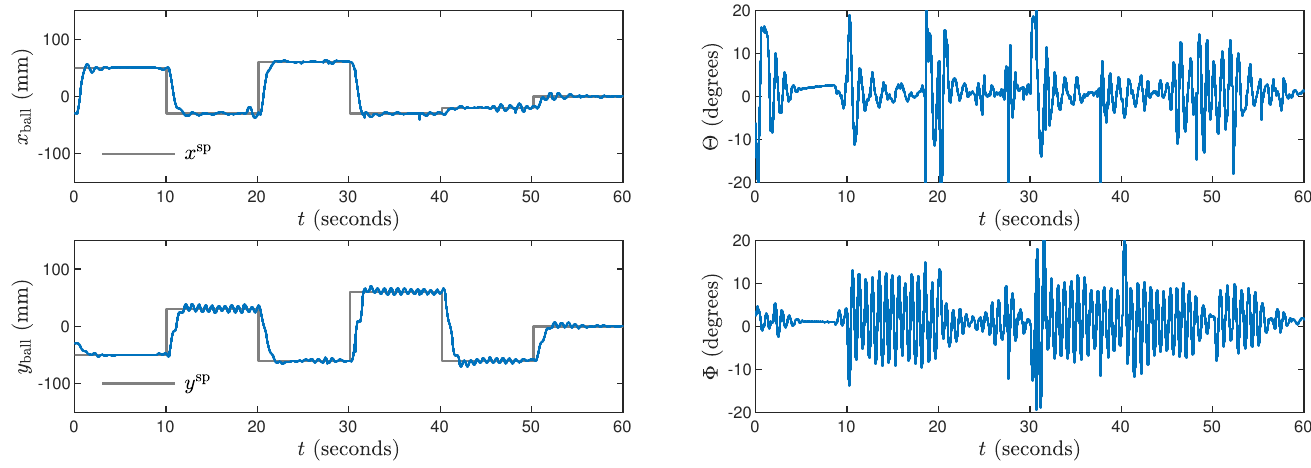
Figure 3. Experimental results of the MPC1 algorithm.